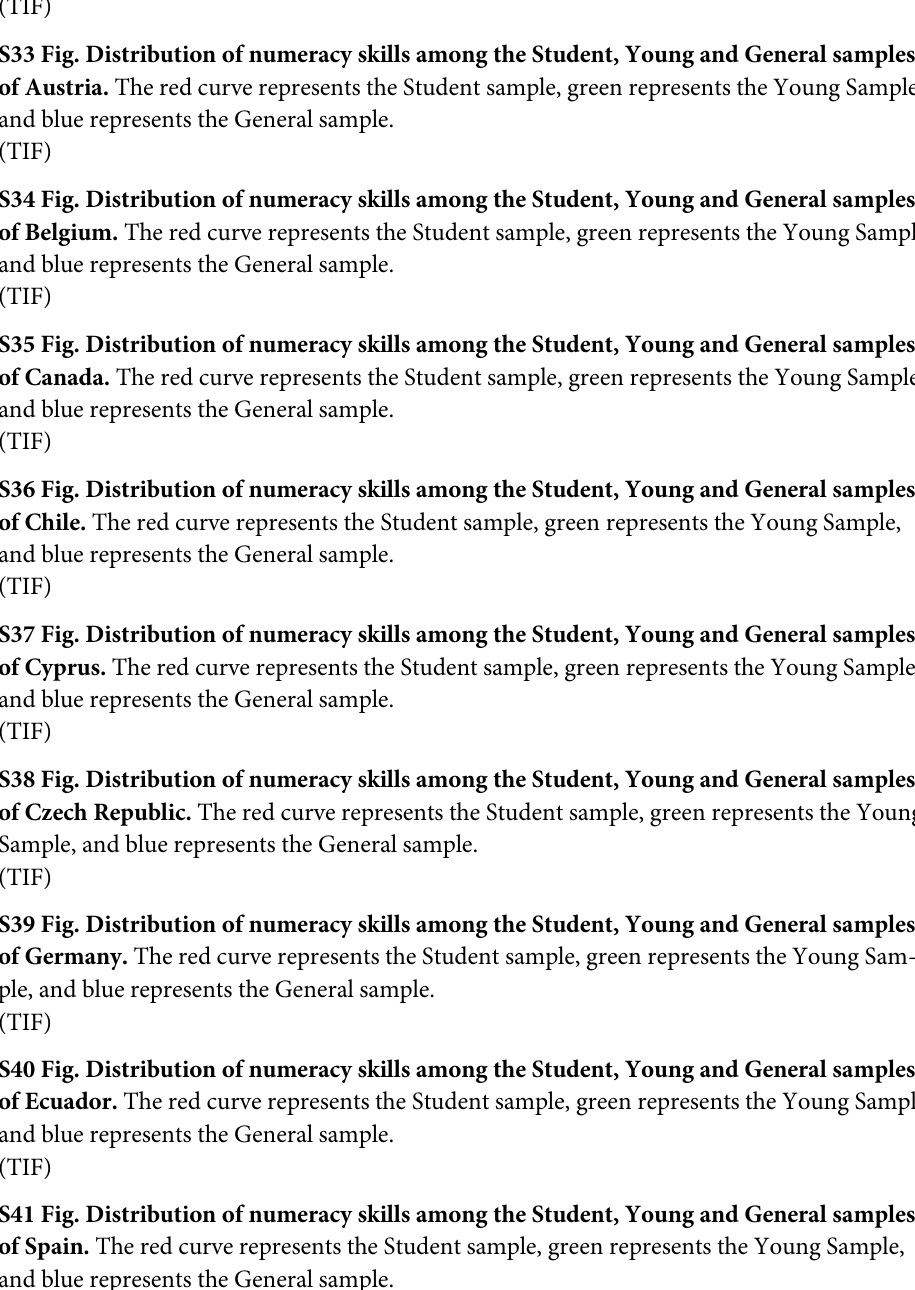
S31 Fig. Distribution of literacy skills among the Student, Young and General samples of Sweden. The red curve represents the Student sample, green represents the Young Sample, and blue represents the General sample. (TIF) S32 Fig. Distribution of literacy skills among the Student, Young and General samples of United States of America. The red curve represents the Student sample, green represents the Young Sample, and blue represents the General sample. (TIF) S33 Fig. Distribution of numeracy skills among the Student, Young and General samples of Austria. The red curve represents the Student sample, green represents the Young Sample, and blue represents the General sample. (TIF) S34 Fig. Distribution of numeracy skills among the Student, Young and General samples of Belgium. The red curve represents the Student sample, green represents the Young Sample, and blue represents the General sample. (TIF) S35 Fig. Distribution of numeracy skills among the Student, Young and General samples of Canada. The red curve represents the Student sample, green represents the Young Sample, and blue represents the General sample. (TIF) S36 Fig. Distribution of numeracy skills among the Student, Young and General samples of Chile. The red curve represents the Student sample, green represents the Young Sample, and blue represents the General sample. (TIF) S37 Fig. Distribution of numeracy skills among the Student, Young and General samples of Cyprus. The red curve represents the Student sample, green represents the Young Sample, and blue represents the General sample. (TIF) S38 Fig. Distribution of numeracy skills among the Student, Young and General samples of Czech Republic. The red curve represents the Student sample, green represents the Young Sample, and blue represents the General sample. (TIF) S39 Fig. Distribution of numeracy skills among the Student, Young and General samples of Germany. The red curve represents the Student sample, green represents the Young Sam- ple, and blue represents the General sample. (TIF) S40 Fig. Distribution of numeracy skills among the Student, Young and General samples of Ecuador. The red curve represents the Student sample, green represents the Young Sample, and blue represents the General sample. (TIF) S41 Fig. Distribution of numeracy skills among the Student, Young and General samples of Spain. The red curve represents the Student sample, green represents the Young Sample, and blue represents the General sample.